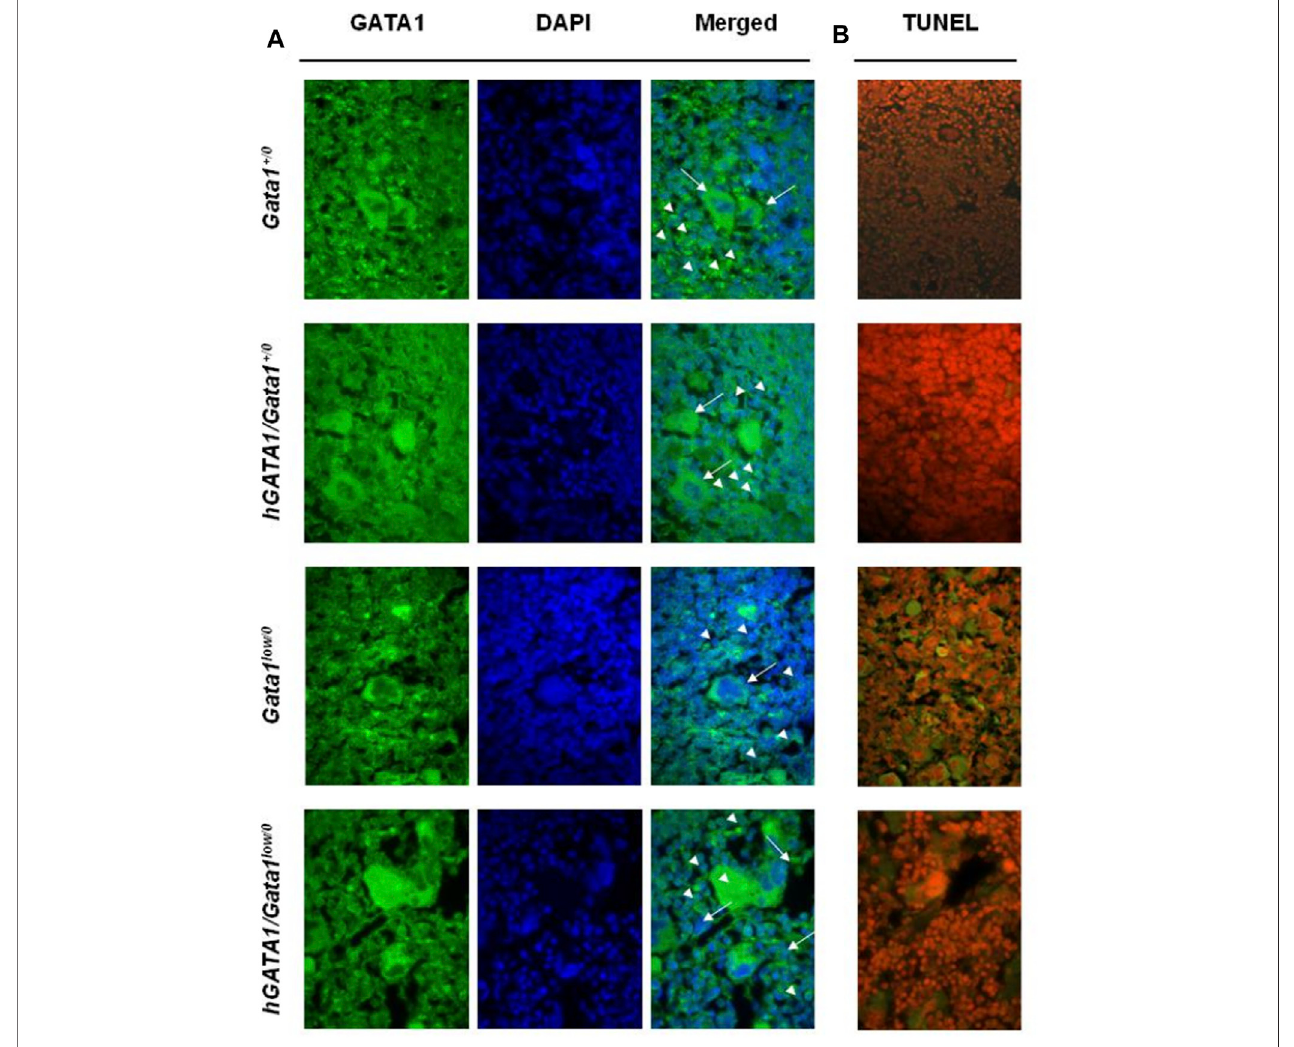
FIGURE 4 | Erythroid cells from adult hGATA1/GATA1 low/0 double mutants contain high levels of GATA1 protein and express low apoptotic rates. (A) Representative confocal microscopy analysis of GATA1 content of spleen sections from wild-type and Gata1 low/0 mice carrying or not the hGATA1 transgene, as indicated. Arrowheadsand arrows indicate representative erythroid and megakaryocytes cells, respectively. GATA1 content(green fl uorescence)increasesinthe nuclei of erythroid cells from hGATA1/Gata1 low/0 mice whereas remains low in their megakaryocytes. (B) Confocal microscopy analysis by TUNEL assay indicates reduced number of apoptotic cells in the spleen from hGATA1/Gata1 low/0 compared to those present in Gata1 low/0 mice. Results are representative of those observed with 3 mice per experimental groups. Similar results were observed by immunostaining with 2 additional mice per experimental groups ( Supplementary Figure S1A ). Original Magni fi cation